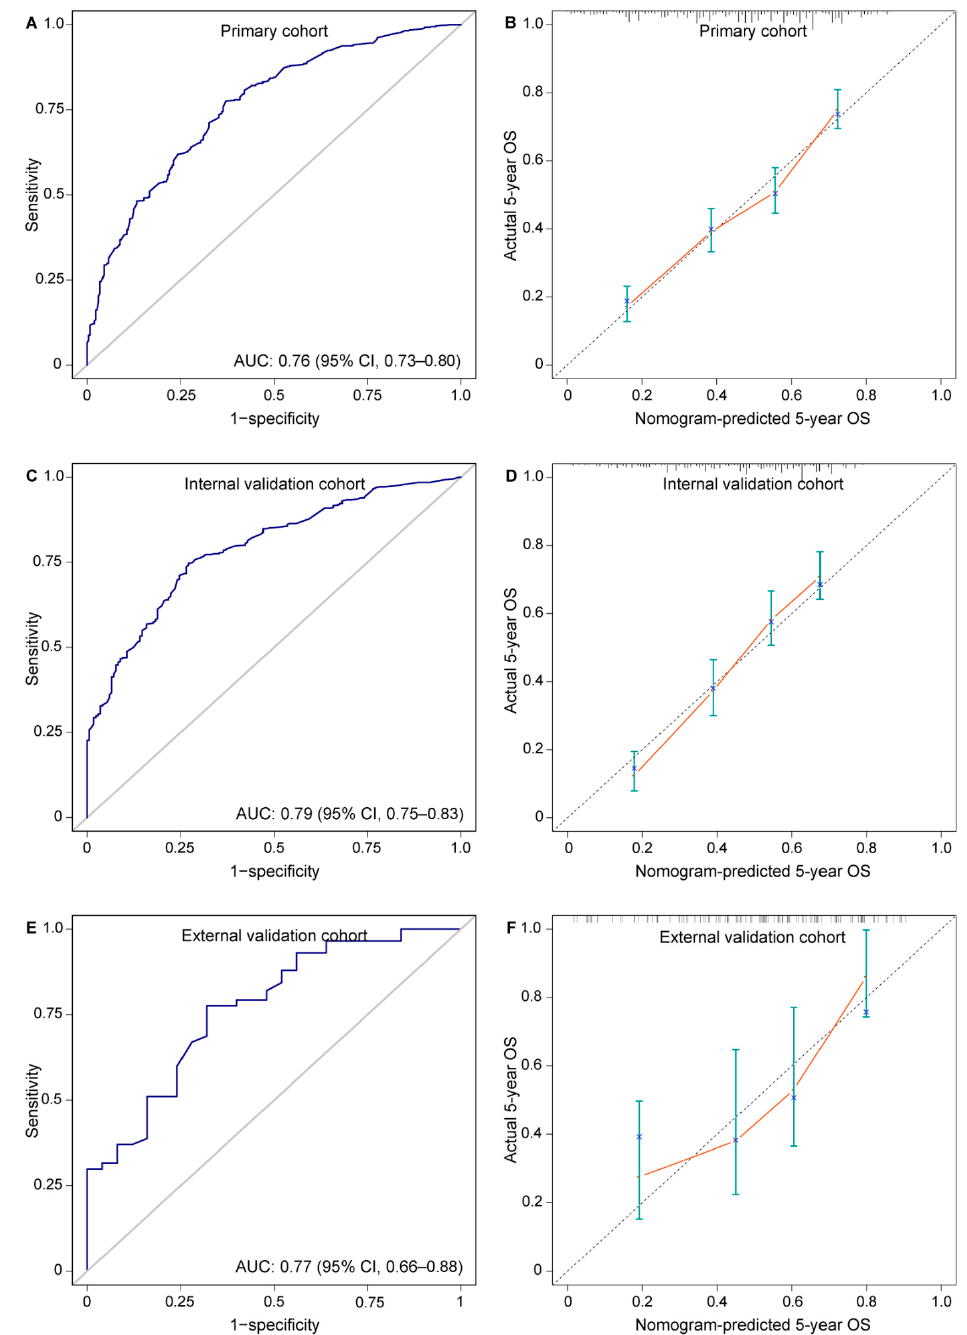
Figure 3. Assessment of nomogram predicting 5-year OS rate in patients with locally advanced esophageal squamous cell carcinoma after esophagectomy. ( A ) AUC 0.76 (95% CI, 0.73–0.80) in primary cohort; ( B ) calibration plot for the prediction of 5-year OS in primary cohort; ( C ) AUC 0.79 (95% CI, 0.75–0.83) in internal validation cohort; ( D ) calibration plot for the prediction of 5-year OS in internal validation cohort; ( E ) AUC 0.77 (95% CI, 0.66–0.88) in external validation cohort; ( F ) calibration plot for the prediction of 5-year OS in external validation cohort. Nomogram-predicted 5-year OS is plotted on the X axis; actual 5-year OS is plotted on the Y axis. AUC, area under the curve; OS, overall